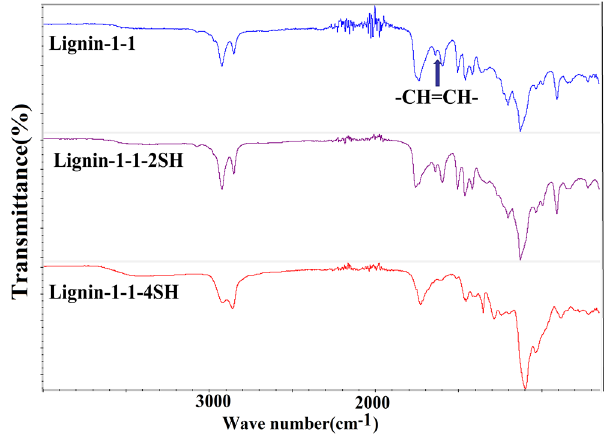
Figure 9. FT − IR of lignin cross − linked polymer compared with that of lignin.